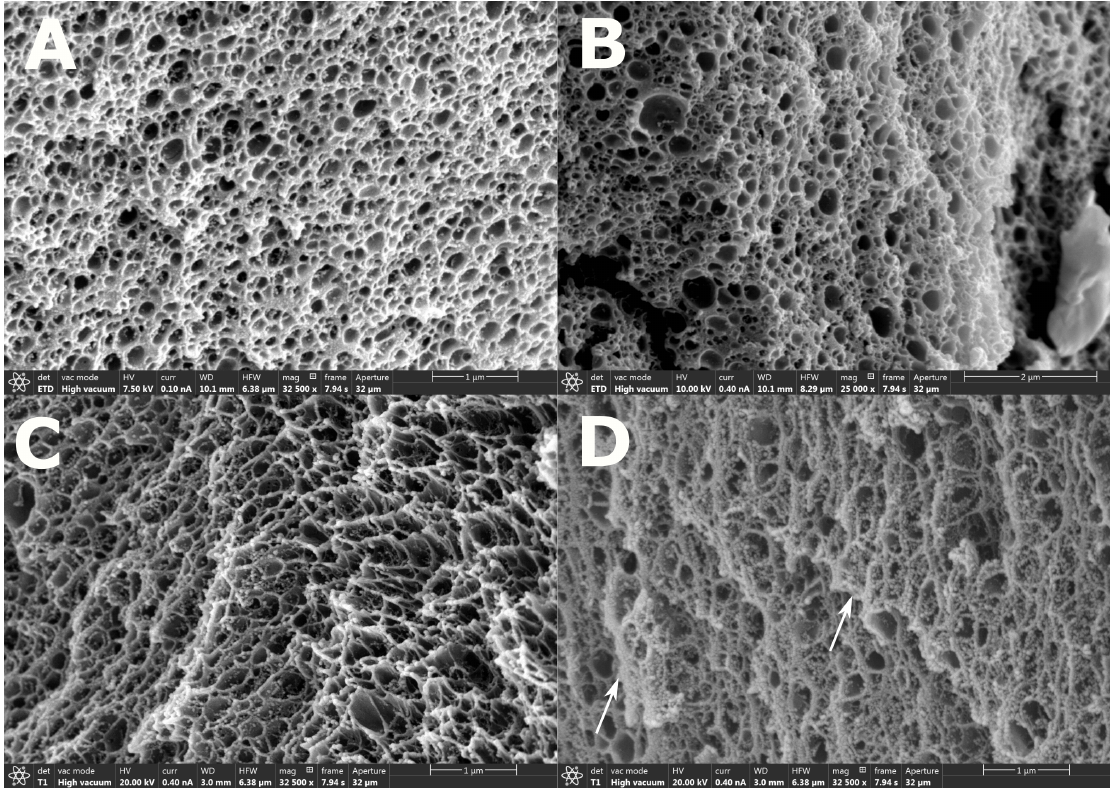
Figure 1. ( A ) Scanning electron microscope (SEM) image of critical point dried (CPD)